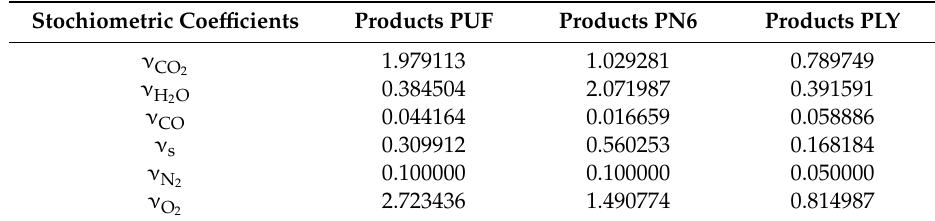
Table 3. Stoichiometric coe ffi cients of materials in reaction phase.